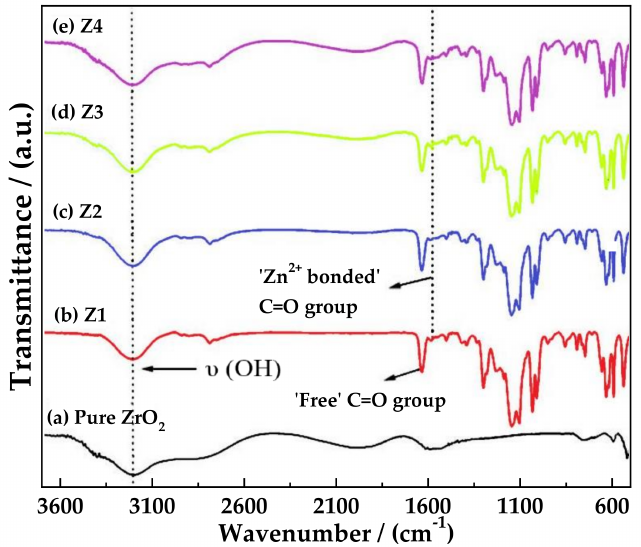
Figure 12. Room temperature ATR-FT-IR spectra of ( a ) pure ZrO 2 ( b – e ) NCPEs with varying concentrations of ZrO 2 in the wavenumber ranging from 4000 to 400 cm − 1 at room